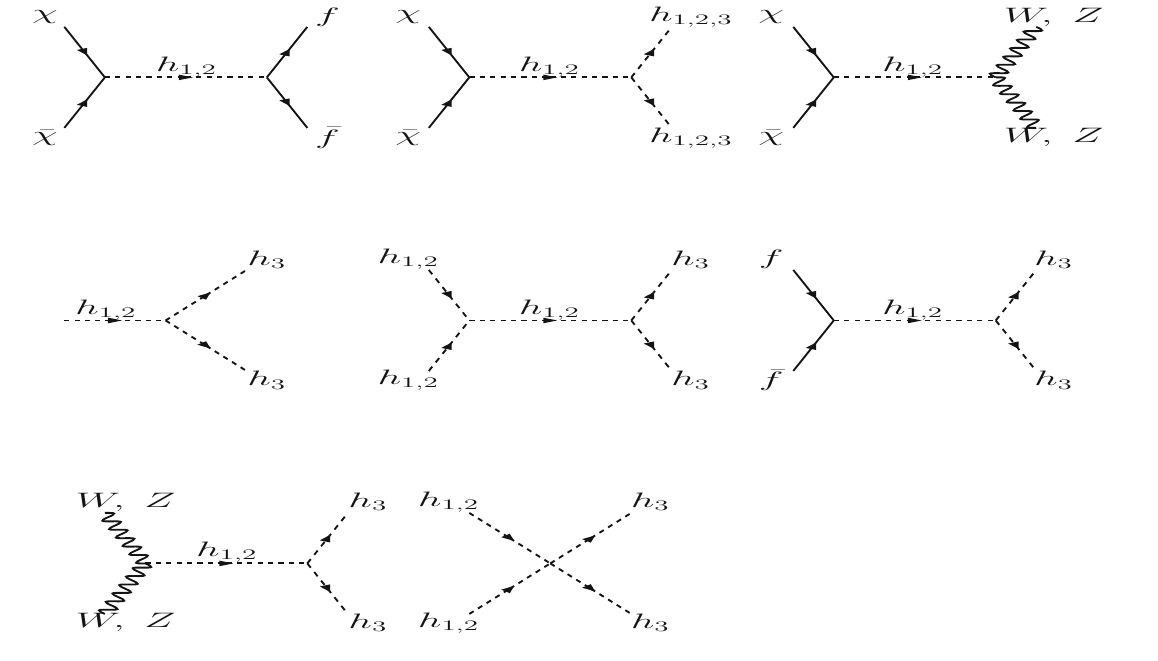
Fig. 1 Feynman diagrams for the fermionic dark matter χ and scalar dark matter h 3 In Eqs. (17)–(20), Y x = n x is the comoving number den- S sity of dark matter candidate x = χ, h 3 while Y eq x is the equilibrium number density, z = m / T where T is the photon temperature and S is the entropy of the